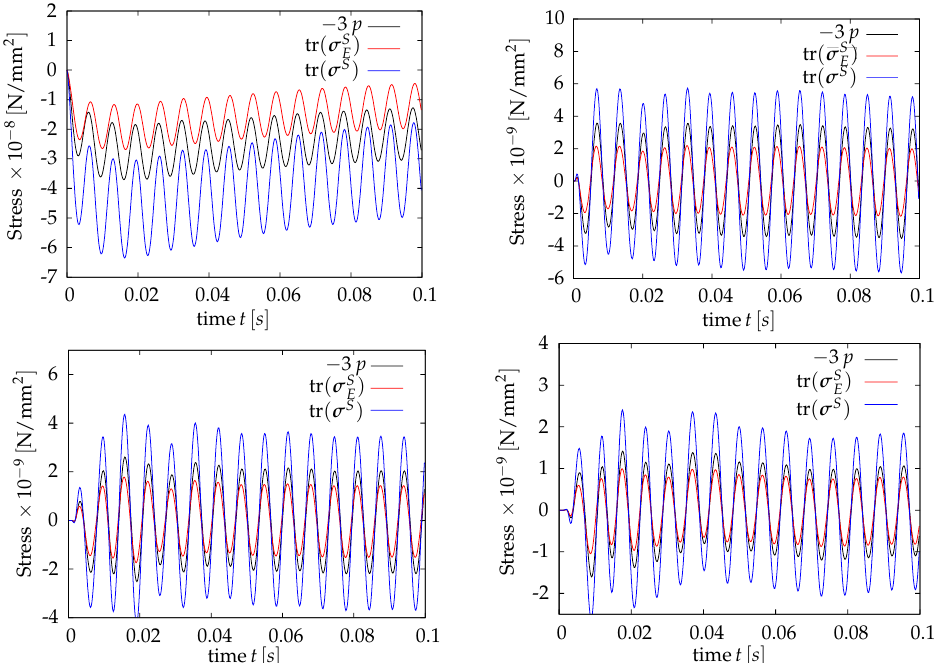
Figure 8. Total solid stress, solid effective stress, and pore-pressure changes over the time range [ 0, 0.1 ] s at points A ( top-left ), B ( top-right ), C ( bottom-left ), and D ( bottom-right ) of the domain for the case of an excitation frequency of f exc =